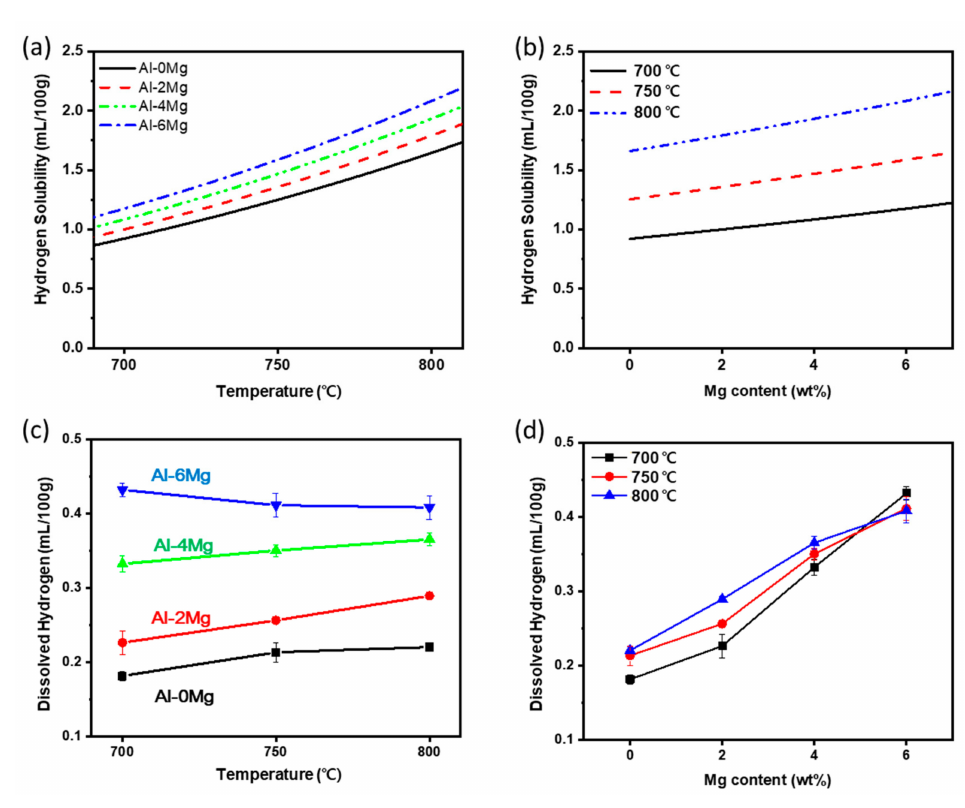
Figure 1. Calculated hydrogen solubility of the Al-Mg alloys according to ( a ) melt temperature T Melt and ( b ) Mg content X Mg ; and measured dissolved hydrogen content in the melt vs ( c ) T Melt and ( d ) Mg